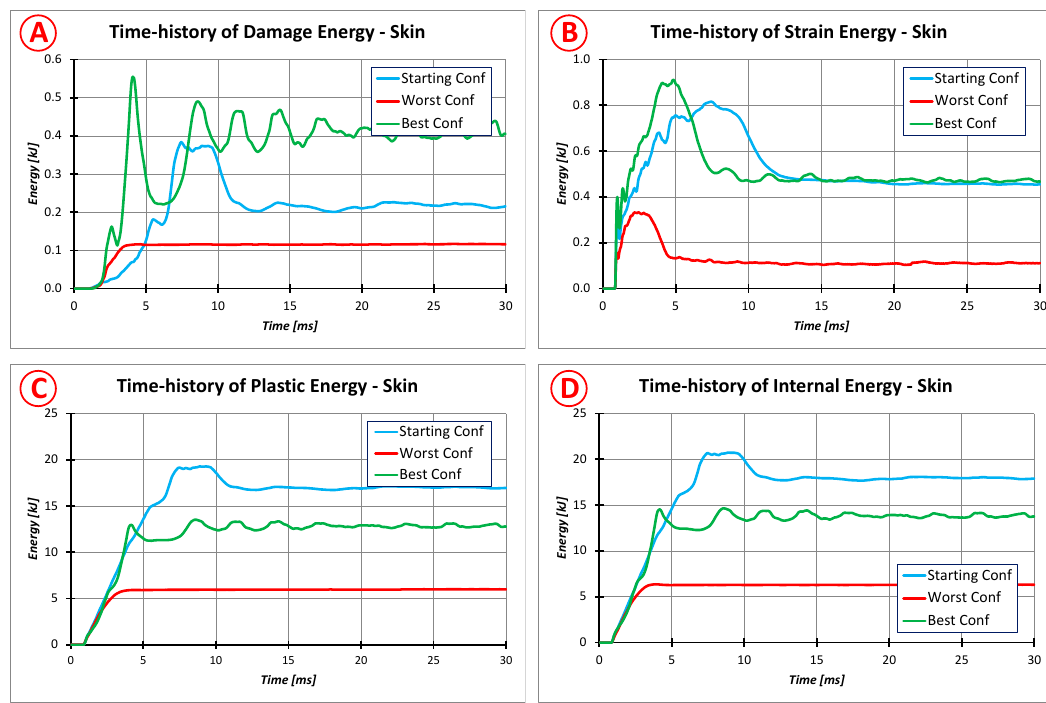
Figure 14. Energy balance for the skin. ( A ) Damage energy; ( B ) strain energy; ( C ) plastic energy; ( D ) internal energy.